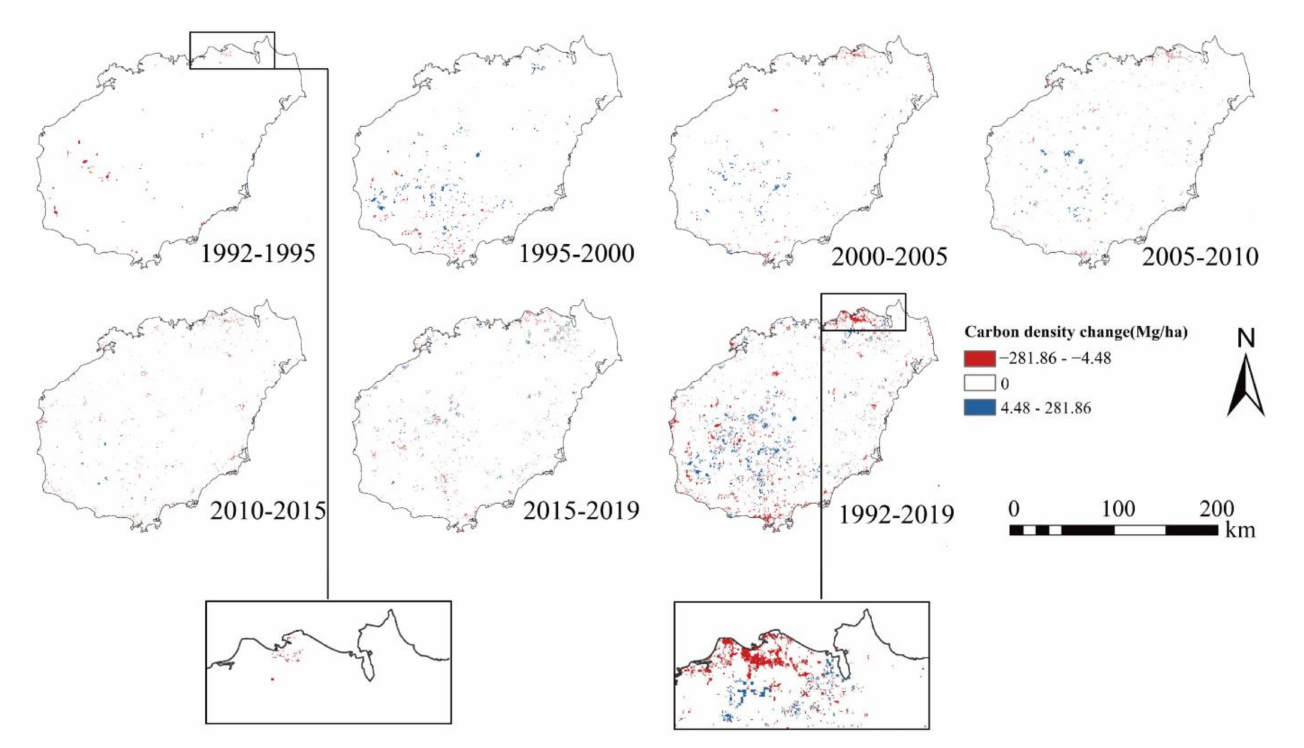
Figure 8. Spatial distribution of carbon storage changes of Hainan Island from 1992 to 2019.